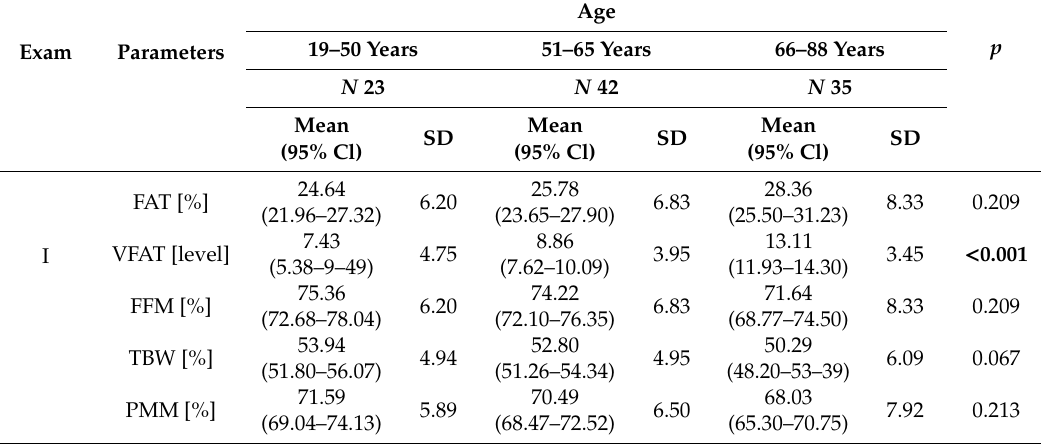
Table 2. Body mass components versus subjects’